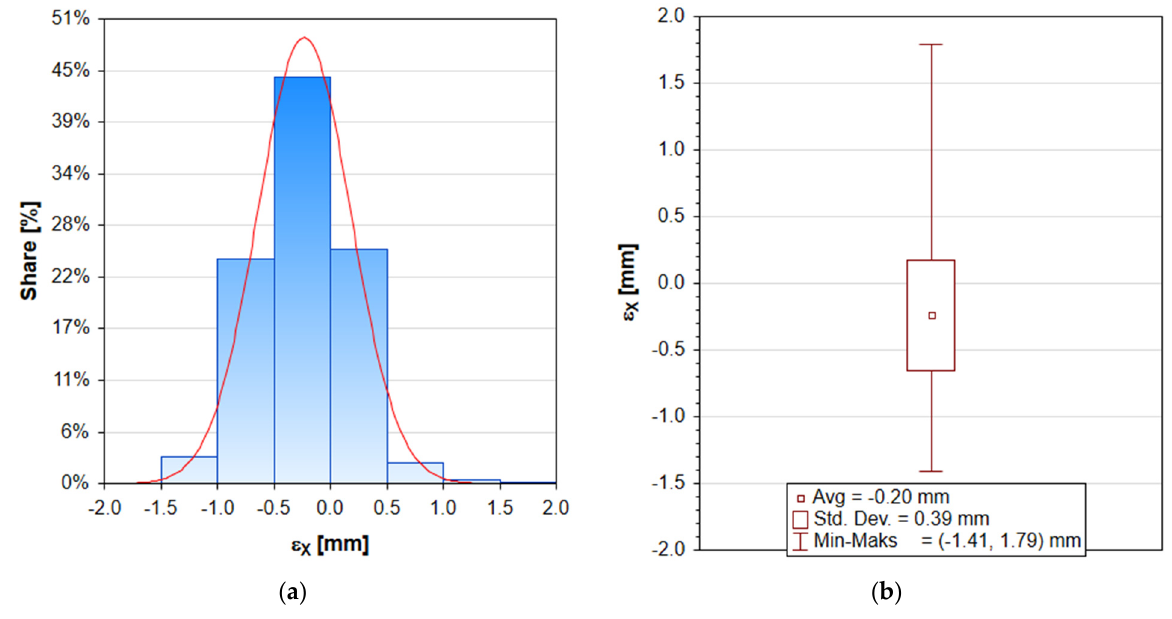
Figure 24. ( a ) Histogram of the distribution of coordinate deviations of the measuring points from the cutting head side surface measured in the direction of the X P axis of the coordinate system associated with the pick holder base and ( b ) basic statistics of this distribution.